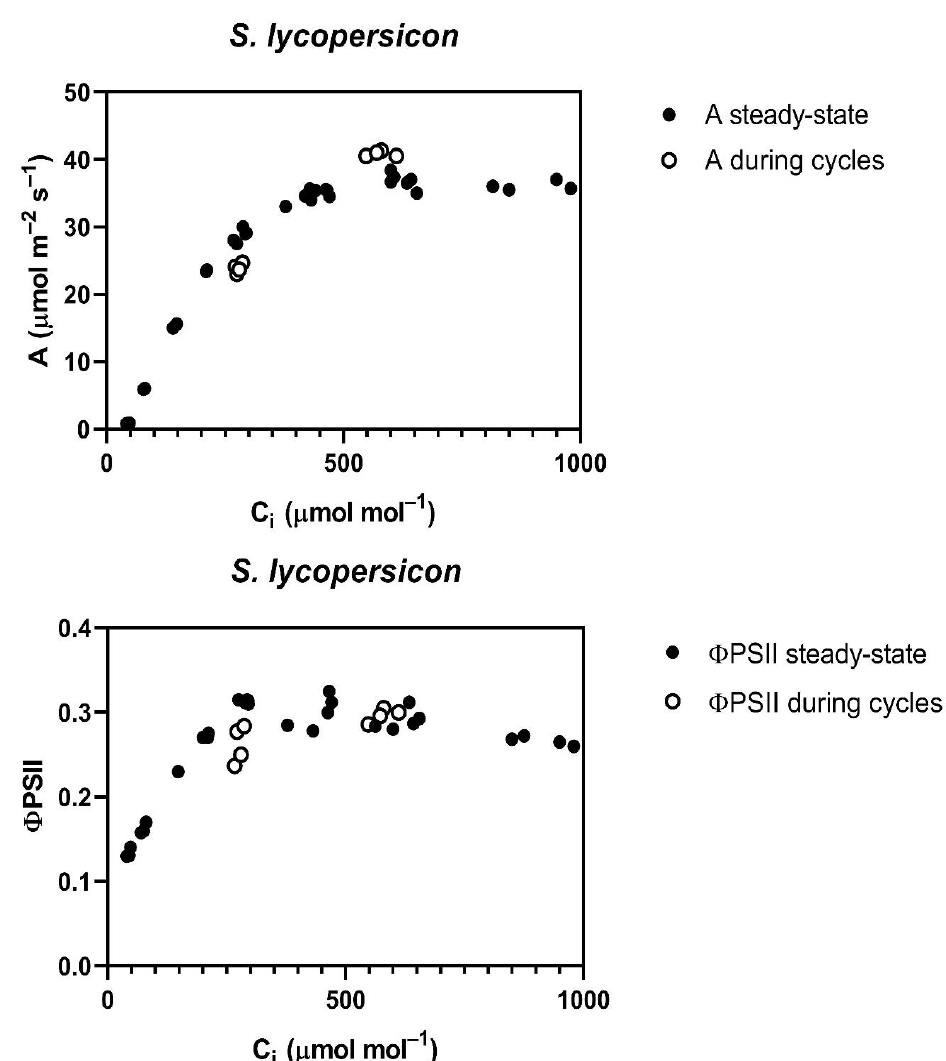
Figure 1. Responses of CO 2 assimilation rate (A) and PSII efficiency ( Φ PSII) as a function of sub- stomatal CO 2 (C i ) before (steady-state) and during cycling of ambient CO 2 in four species. CO 2 was cycled between 400 and 800 µ mol mol − 1 , with one minute at each concentration before changing to the other concentration, for a total of 10 min. Each data point represents a measurement on a different plant taken after values had stabilized during the cycling. Table 1. Mean values of stomatal conductance measured at 400 and 800 μmol mol −1 CO 2 before, during, and 10 min after cycling of CO 2 between 400 and 800 μmol mol −1 , with a full cycle length of 2 min, for a total of 10 min, in five species. Within rows, numbers followed by different letters are different at p = 0.05, using repeated measures ANOVA.